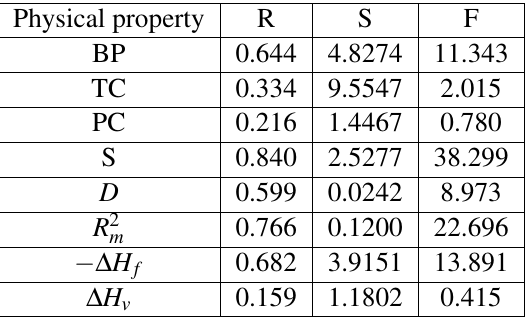
Table 5 Statistical parameters for the linear QSPR model (3).